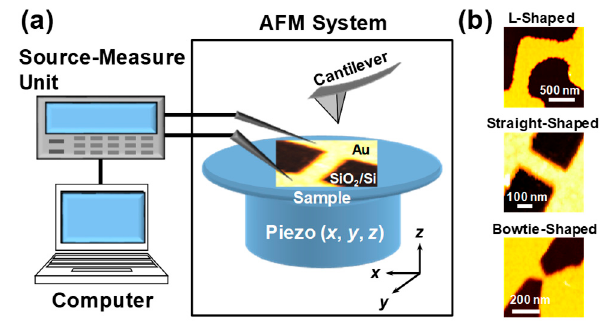
Figure 1. ( a ) Schematic of the experimental setup for in situ atomic force microscopy (AFM) imaging; ( b ) AFM images of Au nanowires of different shapes. ( b ) AFM images of Au nanowires of different